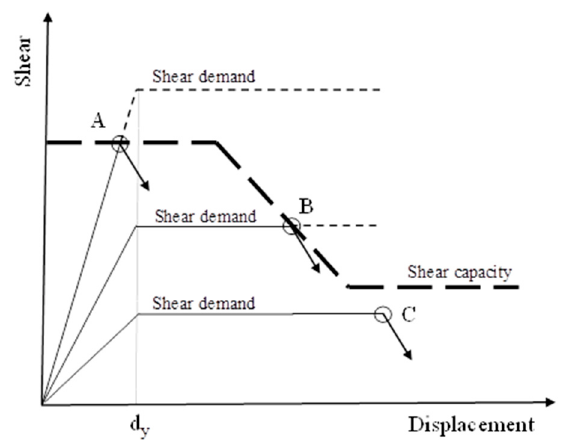
Figure 4. ATC model for shear-strength degradation (d y : yielding displacement). Three cases are considered: (A) shear failure before flexural yielding (pure shear failure); (B) shear failure after flexural yielding (shear-flexural failure); (C) flexural failure.